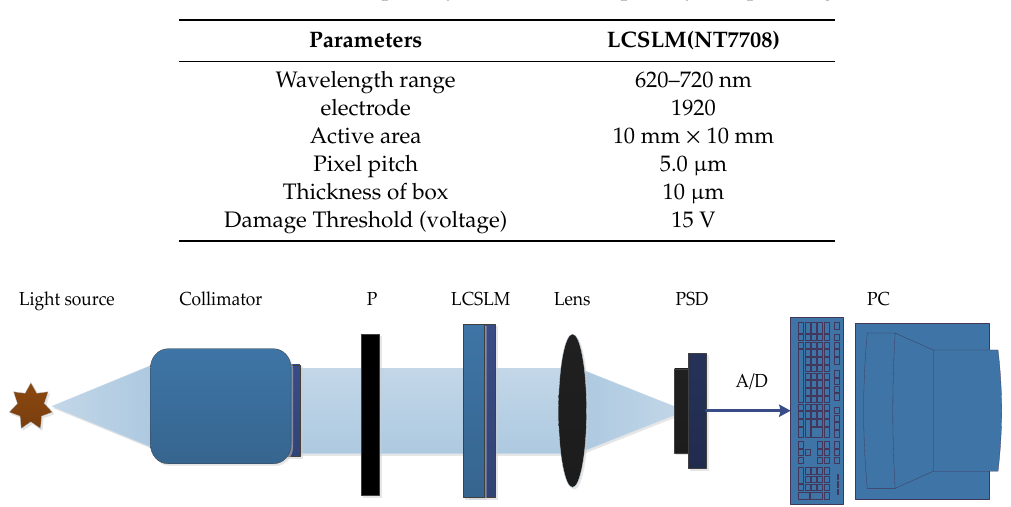
Figure 5. Experimental optical path of overdrive. P: Polarizer, PSD: Position Sensitive Detector, A/D: Analog to Digital Converter, PC: Personal Computer.